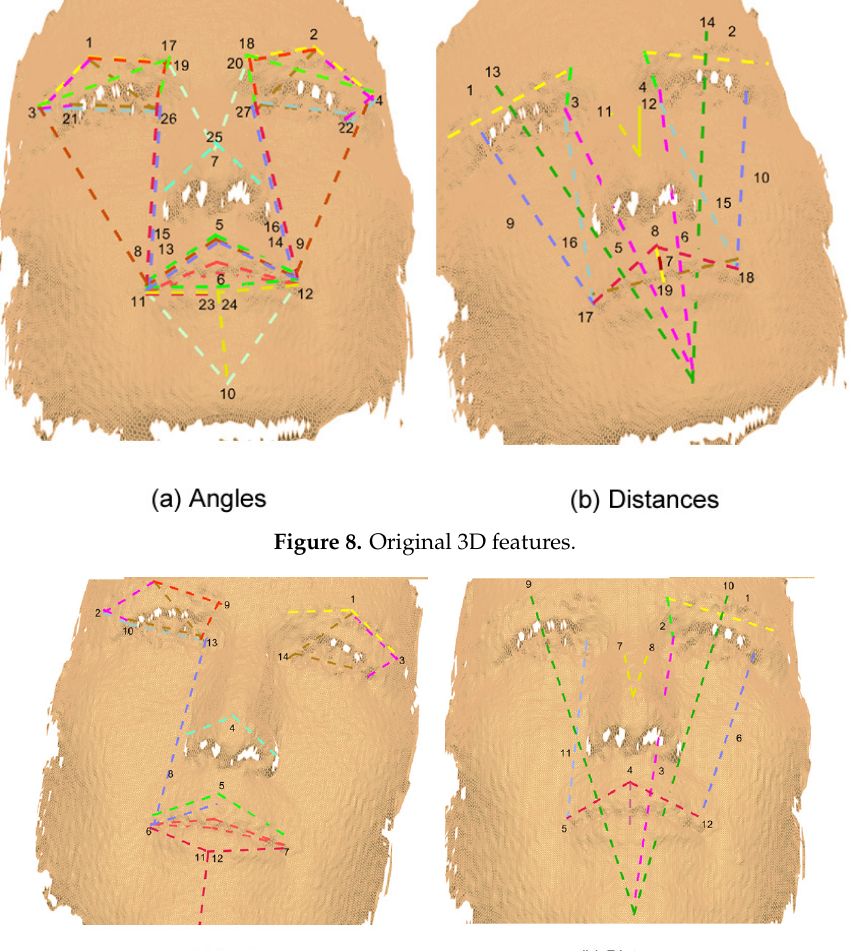
Figure 9. 3D reduced features obtained through a